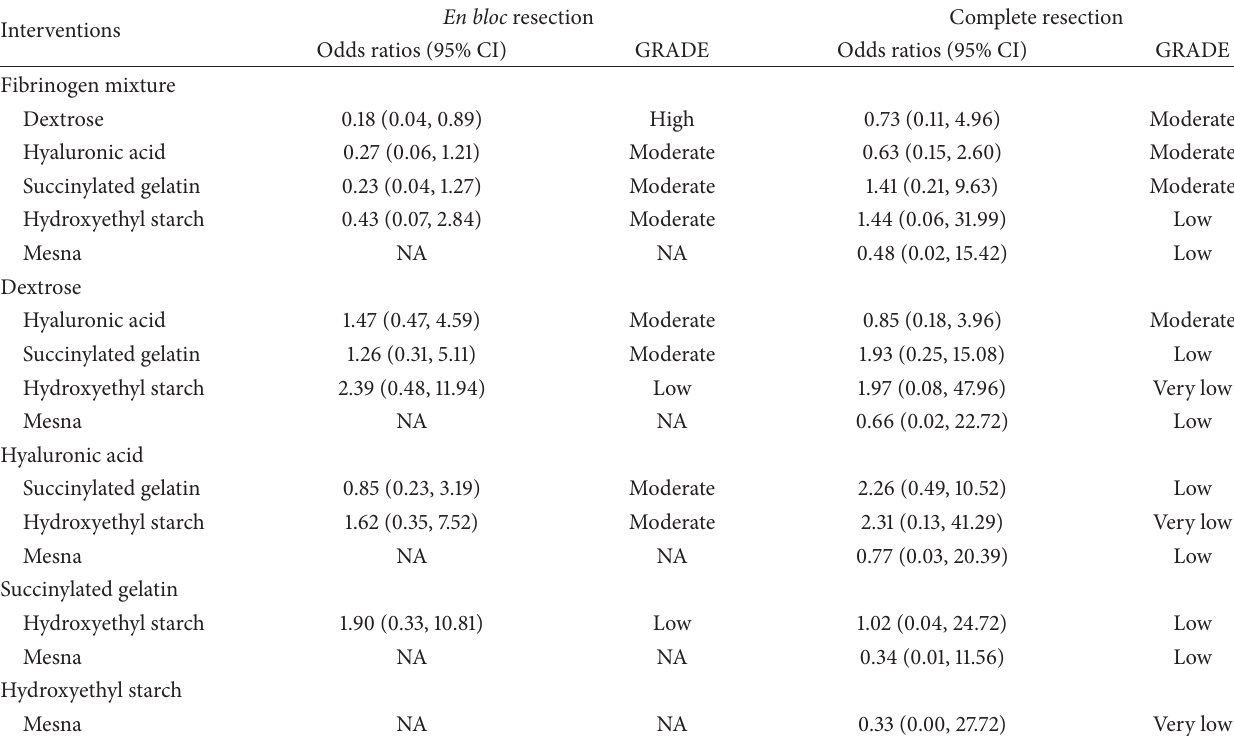
Table 3: Network meta-analysis comparing different classes of injection